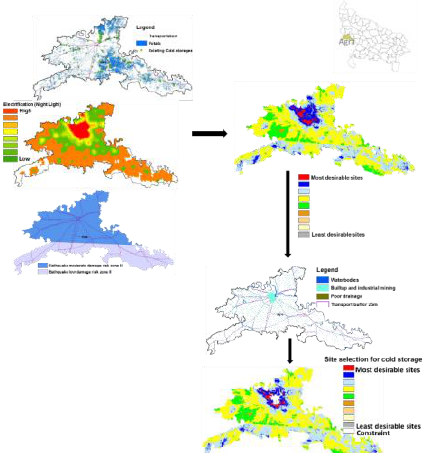
Figure 4. Application of factors and constraints on Agra district